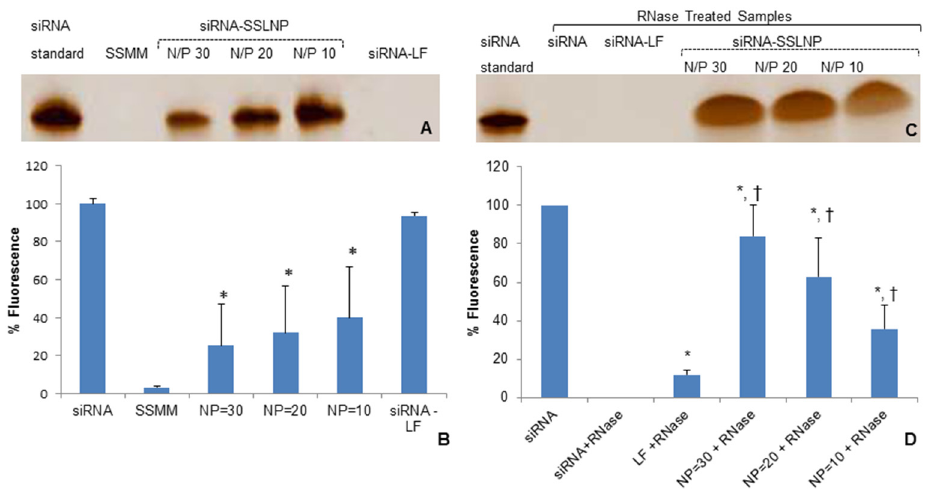
Figure 2. siRNA-SSLNP in vitro characterization: ( A ) Gel retardation assay of different formulations of siRNA, containing 200 nM siRNA per sample, on TBE-urea 15% gel , at a voltage of 180V for 60 min, then stained with 1:500 SYBR Green-II in TBE with mild agitation for 30 min; ( B ) Fluorescence intensities measured by SYBR Green-II exclusion assay of SSMM and siRNA-SSLNP complexes at varying N/P ratios and siRNA with lipofectamine (LF) showing percent of un-incorporated siRNA (* p < 0.05 vs . free siRNA; mean ± SD; n = 3 replicates/group); ( C ) Gel retardation assay of different siRNA formulations after treatment with RNase; ( D ) Fluorescence intensities measured by SYBR Green-II fluorescence assay of different siRNA formulations after treatment with RNase (* p < 0.05 vs . free siRNA; † p < 0.05 vs. siRNA-lipofectamine; mean ± SD; n = 3 replicates/group).